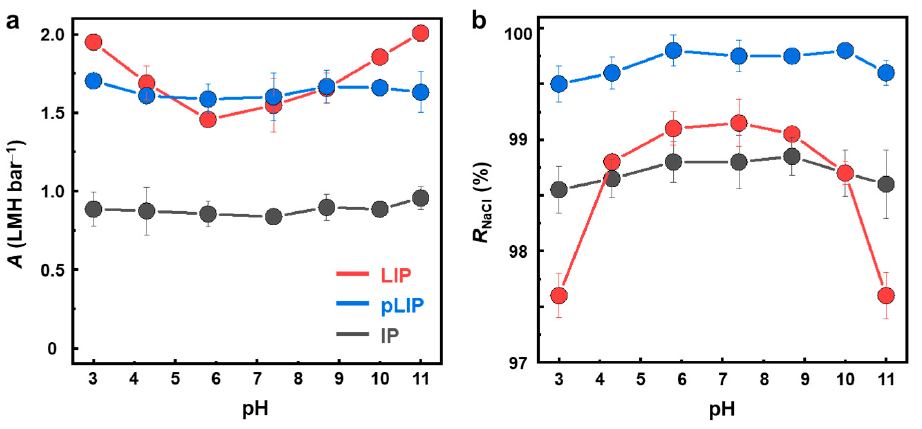
Figure 9. pH stability for the fabricated membranes. ( a ) Water permeance ( A ) and ( b ) NaCl rejection ( R NaCl ) of the LIP, pLIP, and conventional IP membranes as a function of the feed pH.